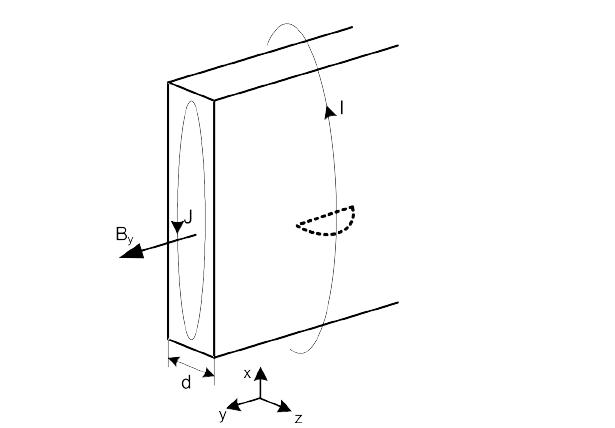
Figure 3. A magnetic field in the transformer plate induced by an external current with density I.